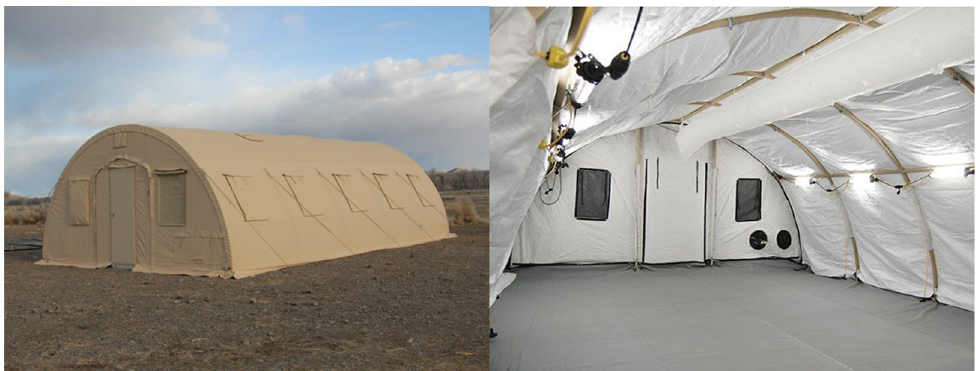
Figure 2. Architecture of a generic HES.